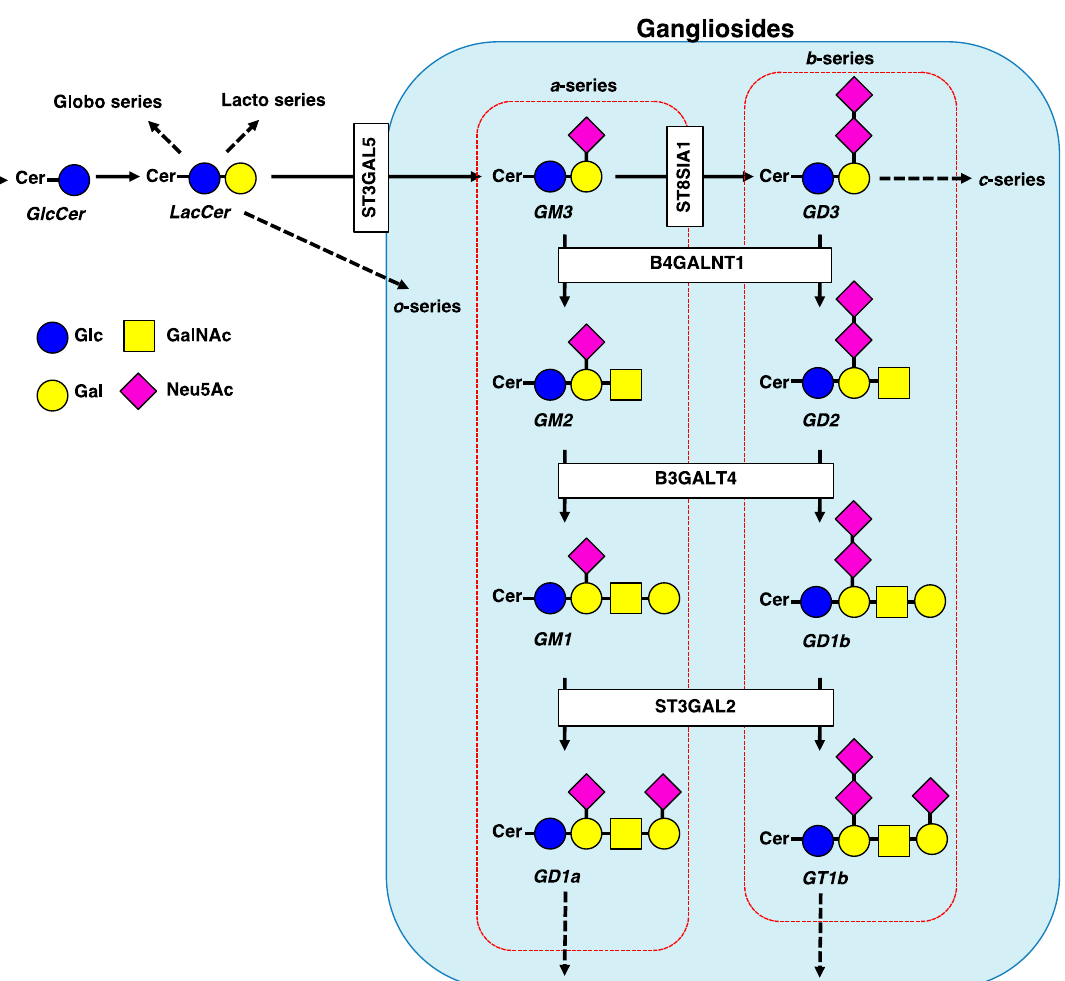
Figure 1. Schematic diagram of major GSL pathways, including gangliosides synthesis glycosyltransferases (ST3GAL5, ST8SIA1, B4GALNT1, B3GALT4, and ST3GAL2). Pathways of the major gangliosides ( a -series and b -series) mentioned in this review are shown within the red dotted rectangles. GSL, glycosphingolipids; Glc, glucose; Gal, galactose; GalNAc, N -acetylgalactosamine; Neu5Ac, N -acetylneuraminic acid; GlcCer, glucosylceramide; LacCer, lactosylceramide.